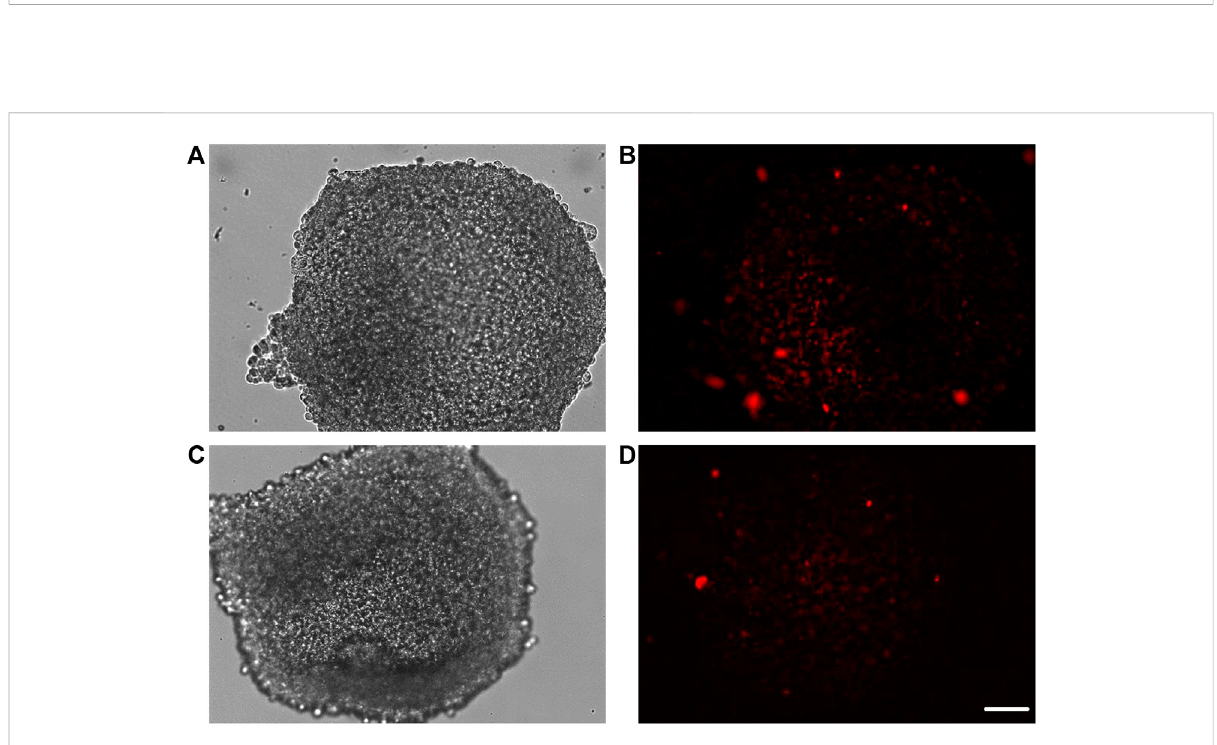
FIGURE 12 Representative images of spheroids obtained by culturing human neuroblastoma SH-SY5Y cells in the lower chamber of LB2/bEnd.3 cells (A – D) .AfterthepassageofgH625-liposomePACAP-Rho,spheroidsretainlabelingforPACAP-Rho (B – D) .ImageswereacquiredasZstackswiththe JuLI Stage fl uorescence recorder and the maximum intensity projection was shown. The scale bar was 250 μ